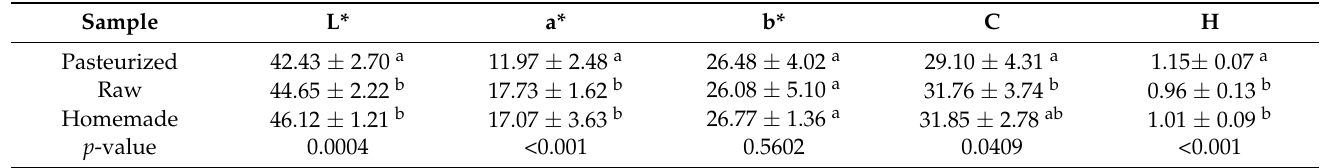
Table 2. CIE L*a*b*, chroma (C) and hue (H) Color parameters of salmorejo samples (mean ± SD).